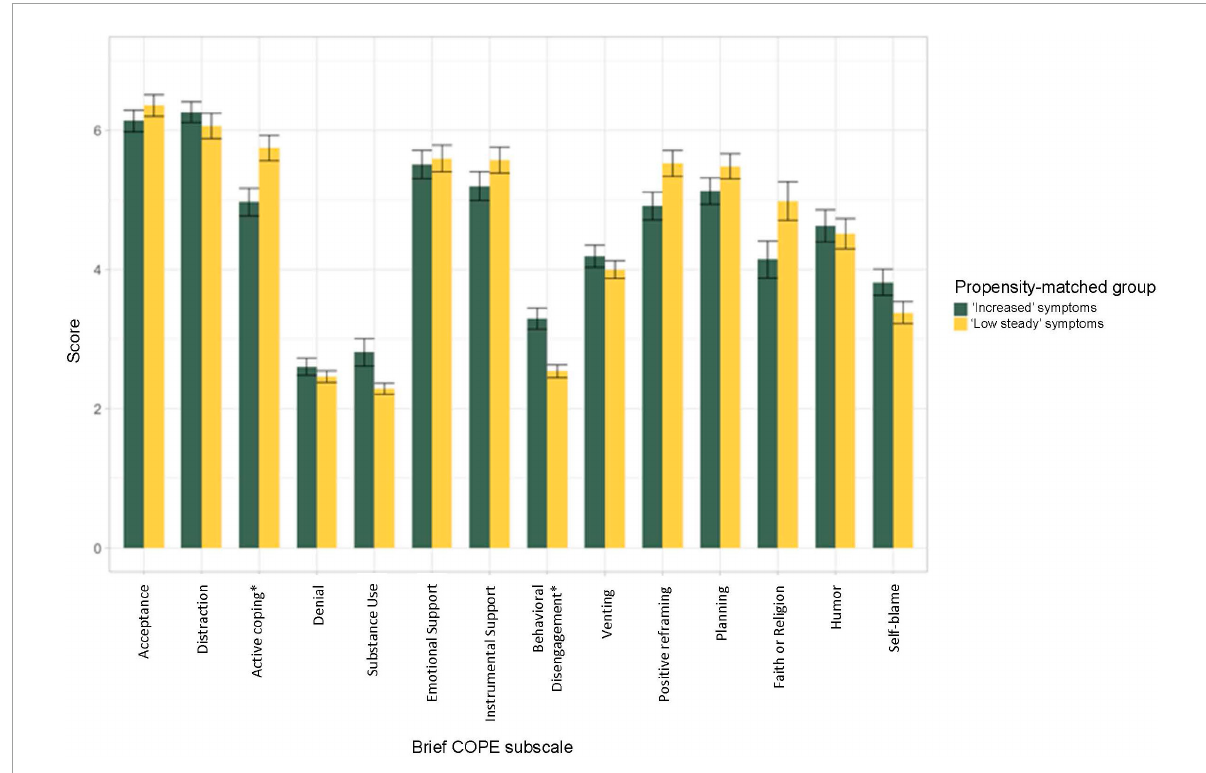
FIGURE2 Average subscale score on the Brief Cope Scale. Subscale scores were averaged across Spring, Summer, and Fall 2020 time points. As compared with the “increased” depression group, the “low stable” depression group exhibited greater scores on the active coping ( W = 1,380, p = 0.003, r = 0.26), positive reframing ( W = 1,528, p = 0.026, r = 0.35), and religion subscales ( W = 1506.5, p = 0.018, r = 0.21), as well as lower scores on the behavioral disengagement subscale ( W = 2,752, p < 0.001, r = 0.35) of the Brief Cope scale (see Supplementary Table 3 for statistical results for all subscales), though only the active coping and behavioral disengagement subscales would meet specified multiple comparison correction thresholds (as indicated by “ ∗ ”).